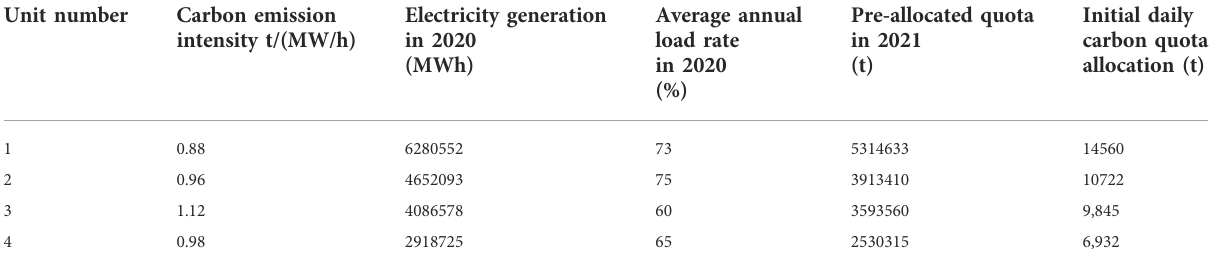
TABLE 2 Simulation parameter setting. Unit